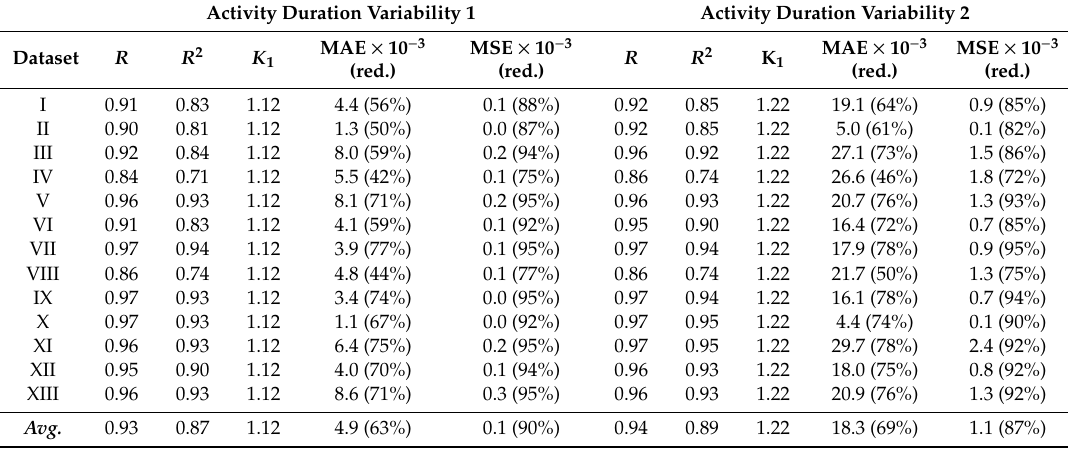
Table 3. Project duration estimates ( µ p / PD ) performance results for the 13 project datasets. MAE—mean absolute error; MSE—mean squared error;